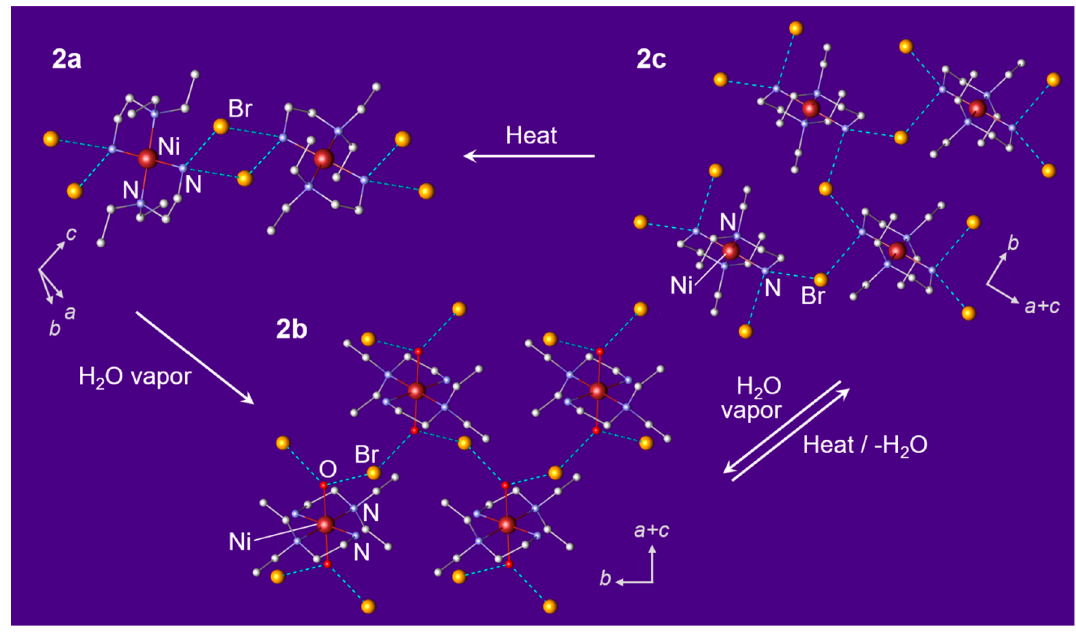
Figure 8. Crystal structure of 2a , 2b , and 2c .